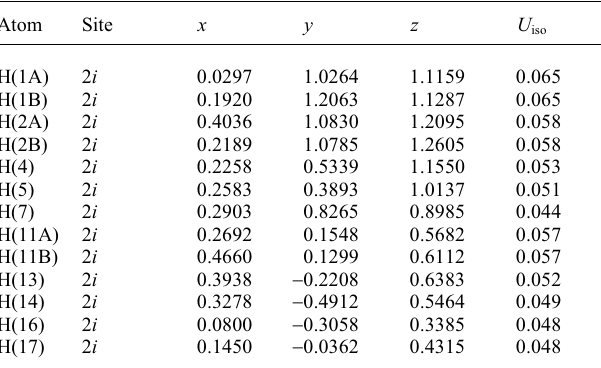
forms dihedral angles of 20.4(3) and 49.9(3)° with the C(3)–C(8) and C(12)–C(17) benzene rings, respectively. The dihedral angle between the C(3)–C(8) and C(12)–C(17) benzene rings is 34.5(3)°. All the bond lengths in the molecule are within normal values [10]. Table 2. Atomic coordinates and displacement parameters (in Å 2 ) .